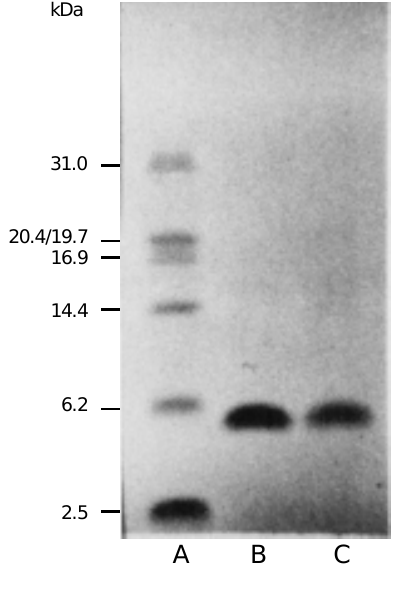
Figure 4. Spectroscopic charac- terization of native and irradiated crotamine (A). UV absorption spectra of native crotamine (1) and irradiated crotamine (2). Concentration was 1.0 mg/ml in 150 mM NaCl. Inset , Stern- Volmer plot of the native (1) and irradiated (2) crotamine fluores- cence quenching by iodide. Cro- tamine concentration was 4 x 10 -8 M in 100 mM phosphate buffer, pH 7, at 25 o C (B). Circu- lar dichroism spectra of native crotamine (1) and irradiated cro- tamine (2). Concentration was 125 µg/ml in 20 mM sodium ac- etate buffer,